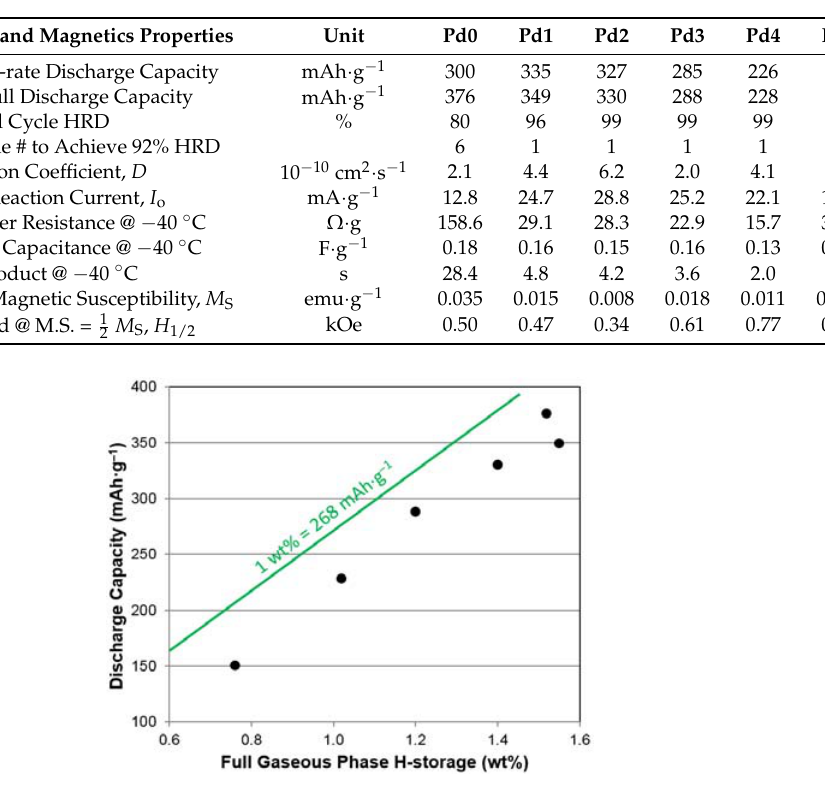
Figure 13. Comparison of the electrochemical discharge capacity vs. gaseous phase H-storage capacity. The green line shows the conversion between two properties, which sets the upper bound for electrochemical discharge